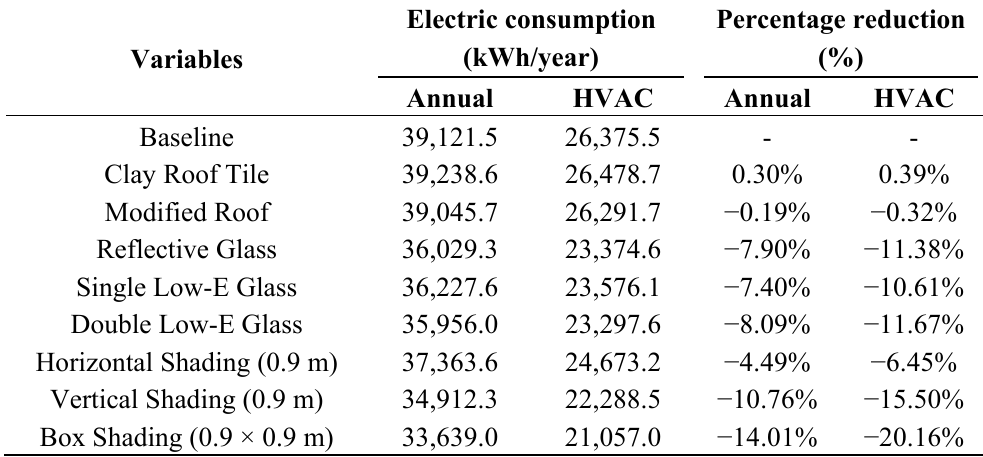
Table 9. Comparison of the electricity consumption and percentage reduction among different